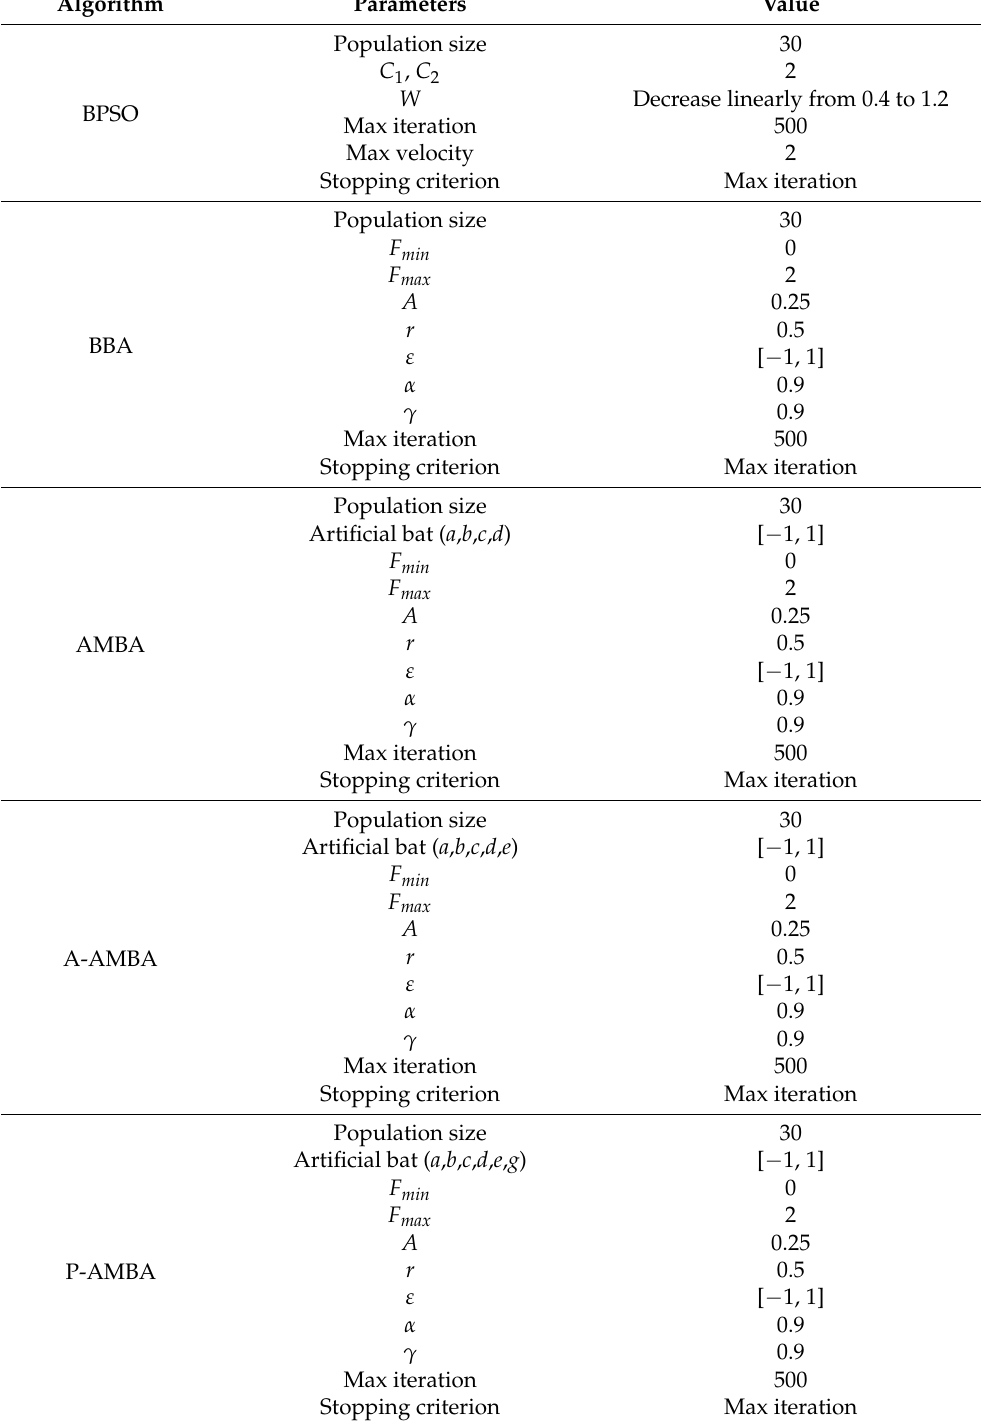
Table 3. Initial parameters for phase angle-modulated bat algorithm (P-AMBA), amplitude angle- modulated bat algorithm (A-AMBA), angle-modulated bat algorithm (AMBA), binary bat algorithm (BBA), and binary partical swarm algorithm (BPSO) in the knapsack